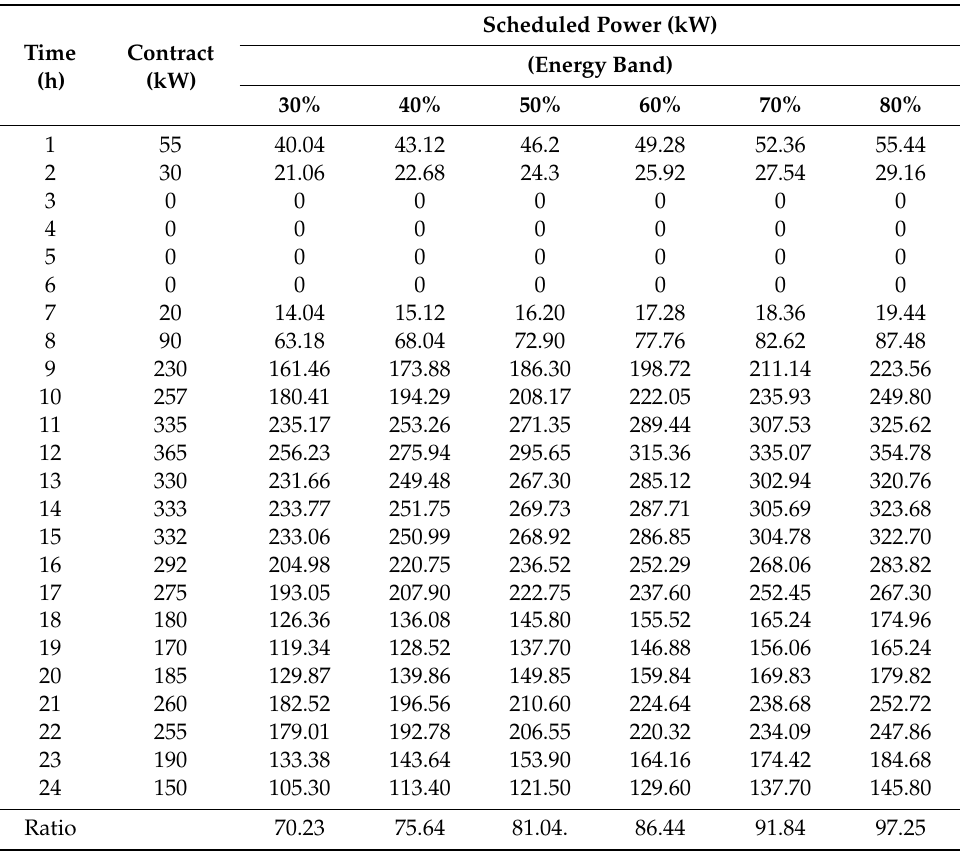
Table 2. Comparison of MG operational